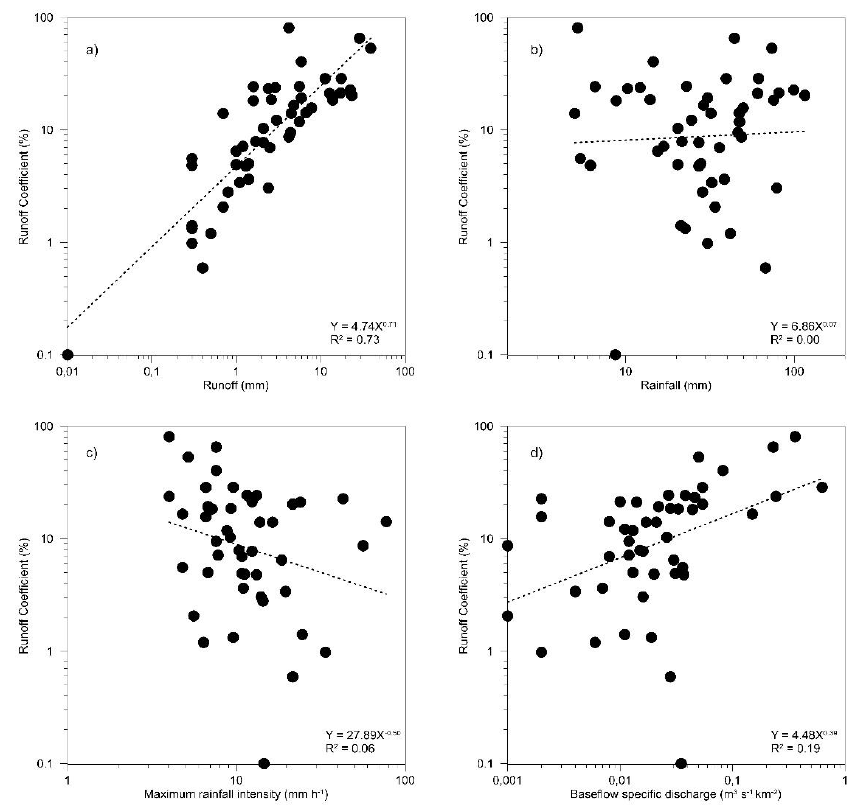
Figure A2. Relationship between ( a ) R and R c coe ffi cient, ( b ) rainfall and R c , ( c ) IP max 30 intensity and R c and ( d ) base-flow specific discharge and R c at Es Fangar Creek. Dotted lines show significant (p < 0.01) fits with a power function.